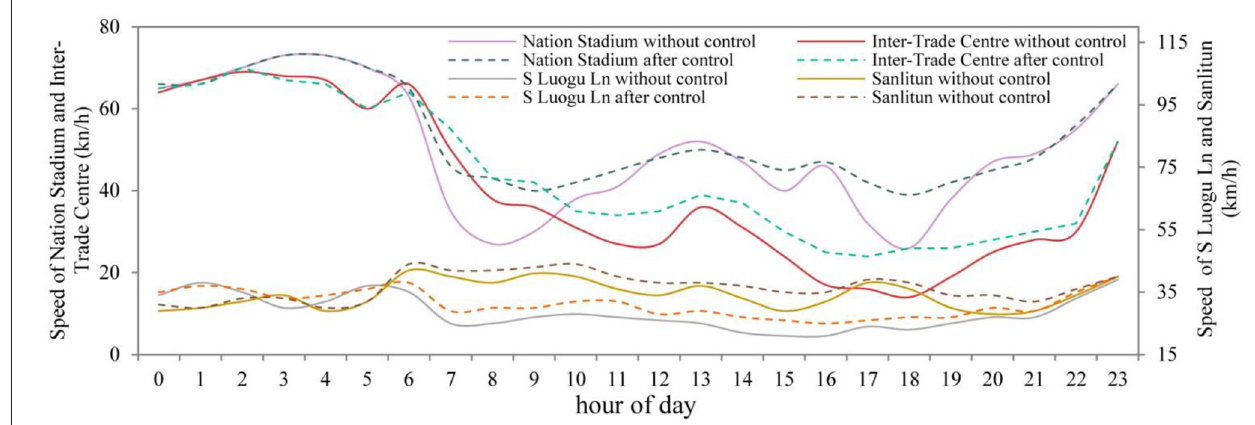
FIGURE 13 | Median speed of the four regions before and after control.